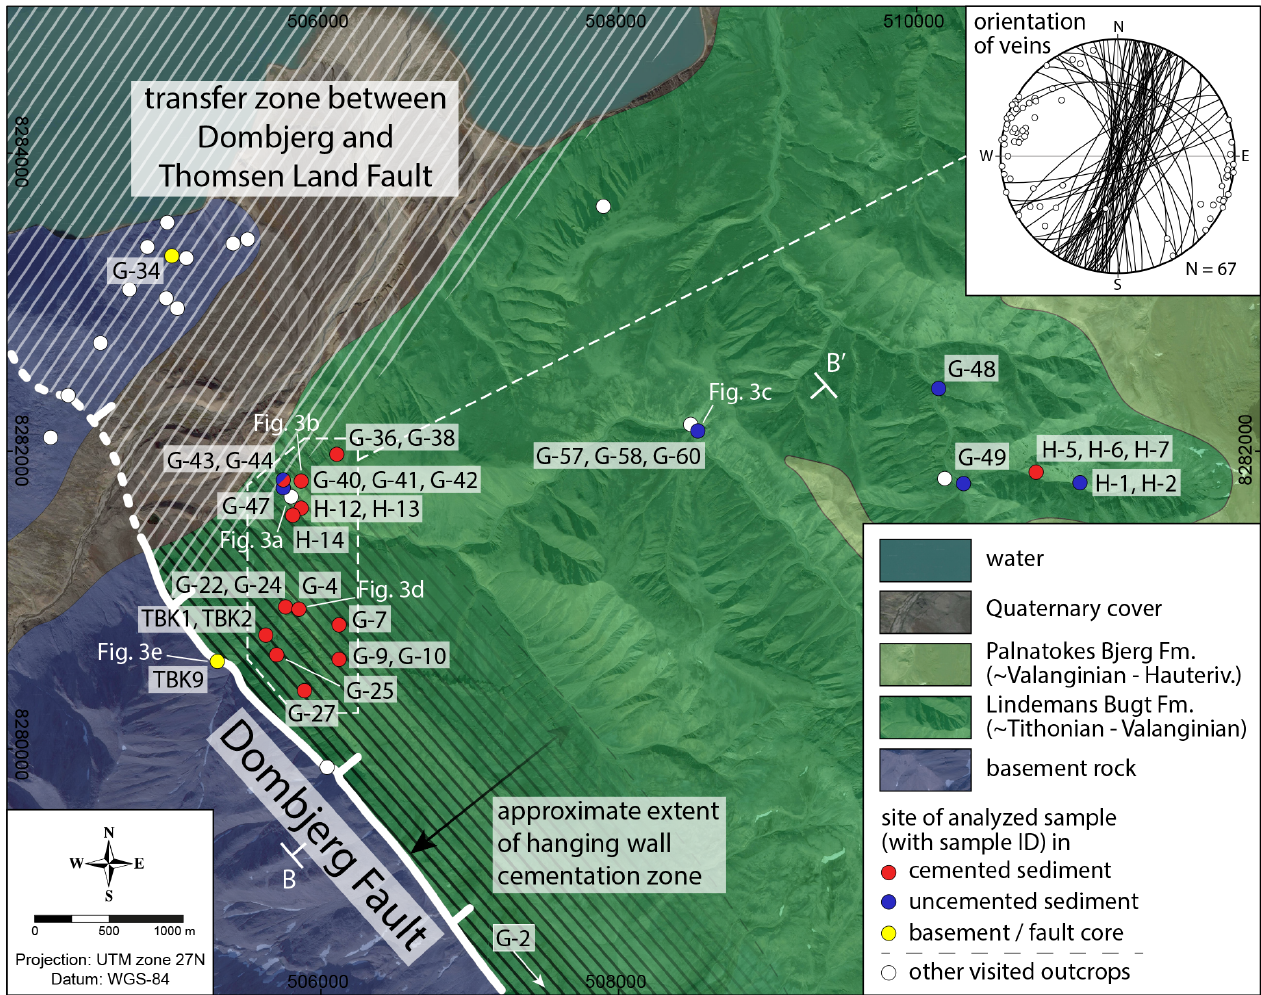
Figure 2. Geological map of study area with locations of visited outcrops and samples analyzed in this study. Inset of stereographic plot shows orientation of all collected calcite veins in the hanging wall. Profile B-B (cid:48) shown in Fig. 11. Sample coordinates are provided in Table S1 in the Supplement. See Fig. 1b for location. Base satellite image from © Google Maps.